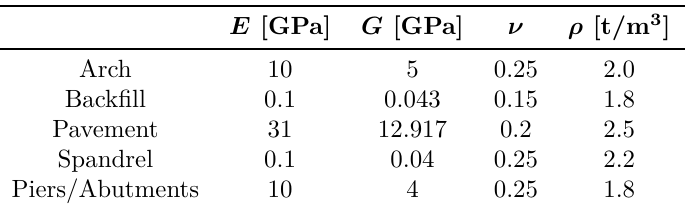
Table 1. Elastic properties considered in this case study.